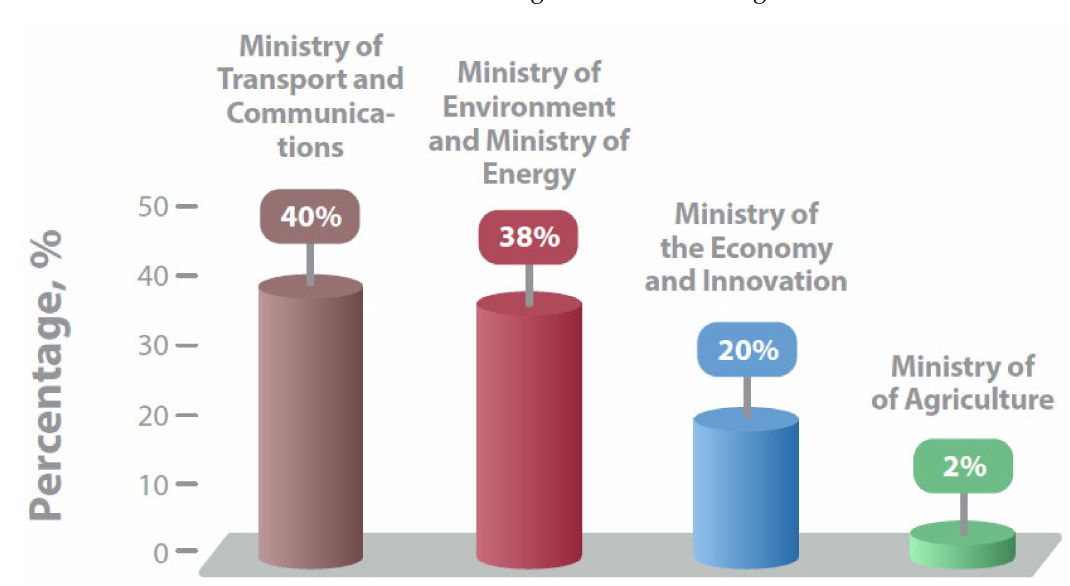
Figure 5. Obligations to save energy distribution between ministries (from 1 January 2021 to 31 December 2030).